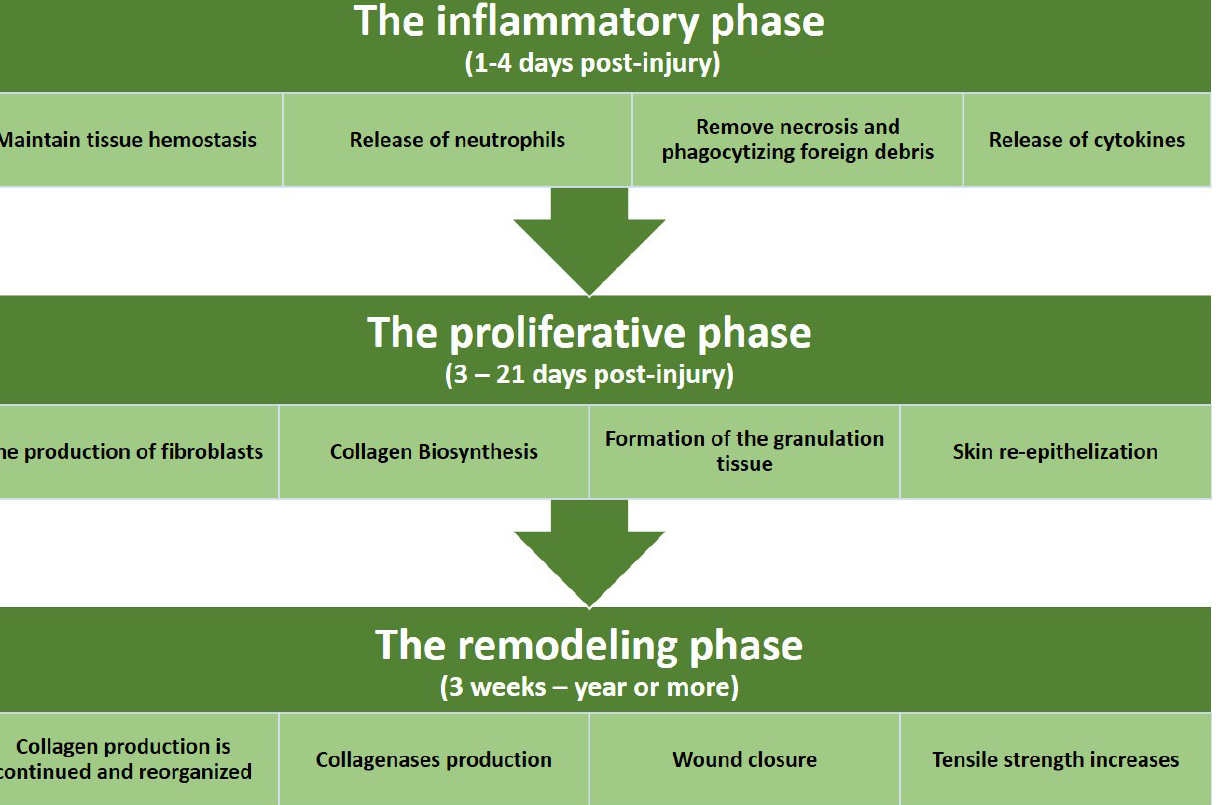
FIGURE 1 - Normal wound Phases and main events